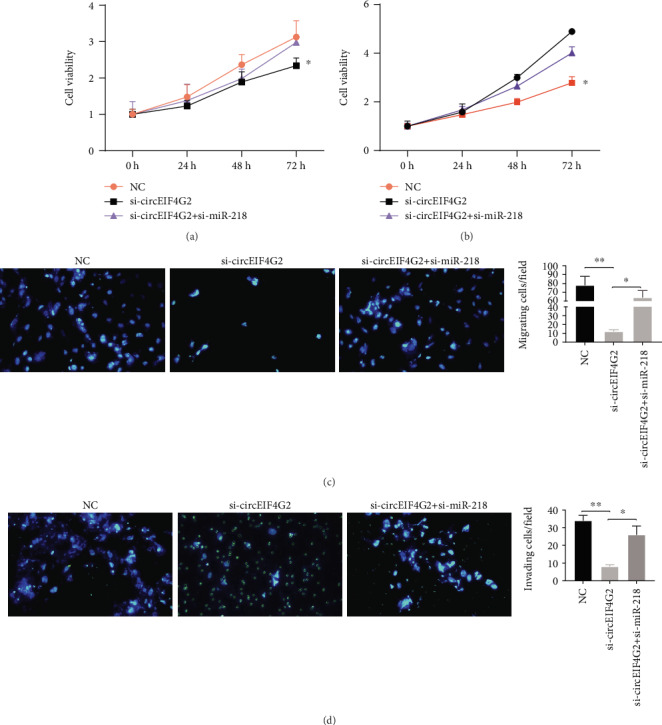
Silencing of miR-218 reverses the effects of circEIF4G2 knockdown in OS. (a and b) Silencing of miR-218 reversed the effects of decreased cell proliferation in circEIF4G2 knockdown HOS (a) and MG63 (b) cells. (c) Silencing of miR-218 reversed the effects of decreased cell migration in circEIF4G2 knockdown HOS cells. (d) Silencing of miR-218 reversed the effects of decreased cell invasion in circEIF4G2 knockdown HOS cells.